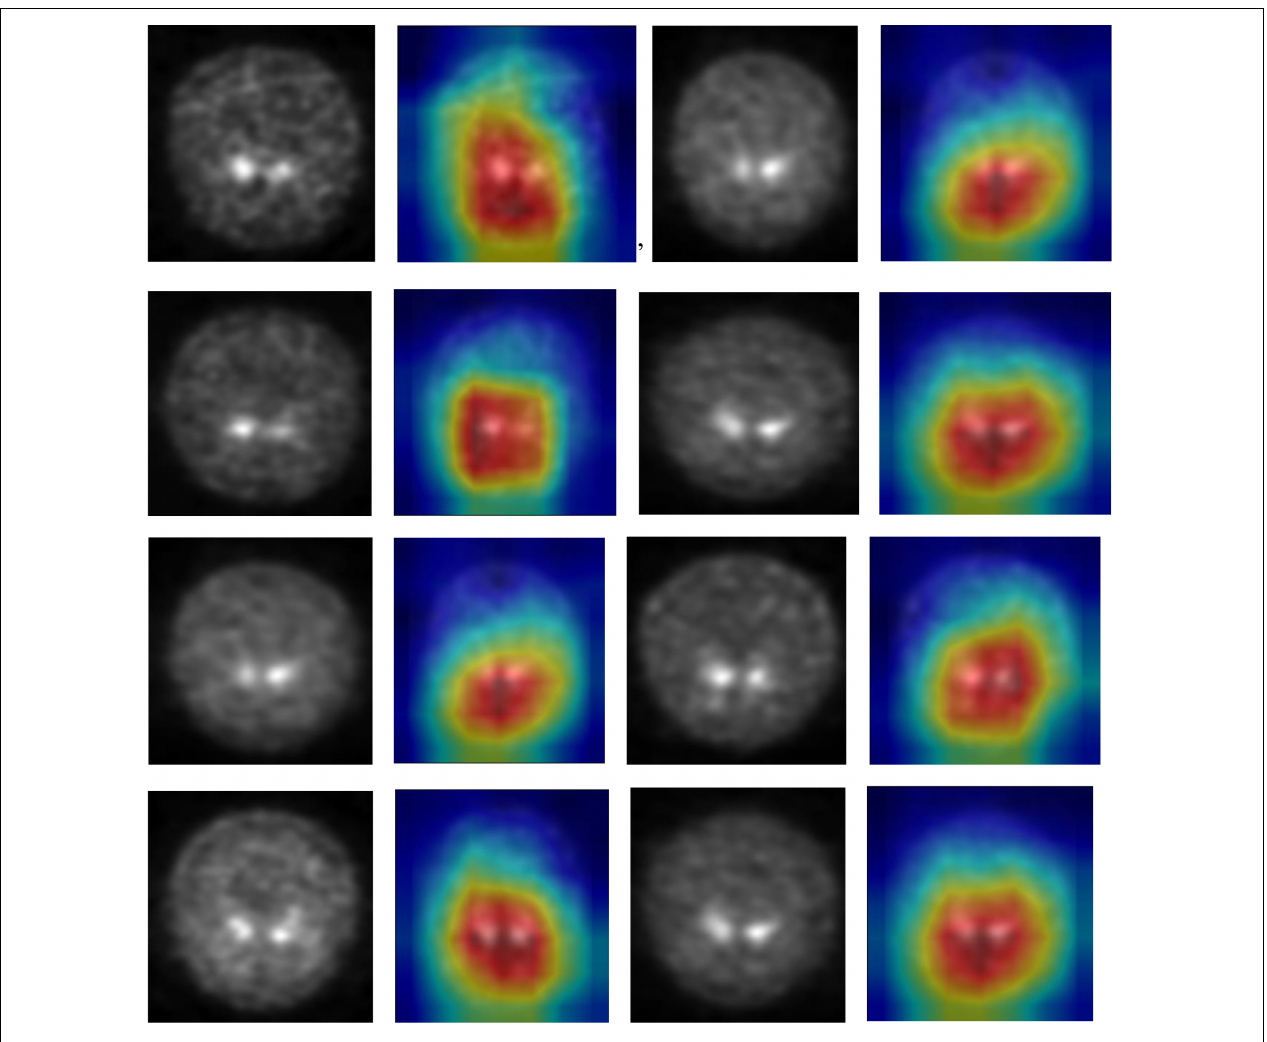
FIGURE 7 | Soft attention map visualisation of PD patients with the ROI highlighted.